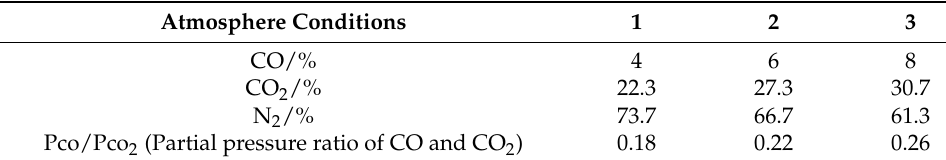
Table 4. Atmosphere conditions.